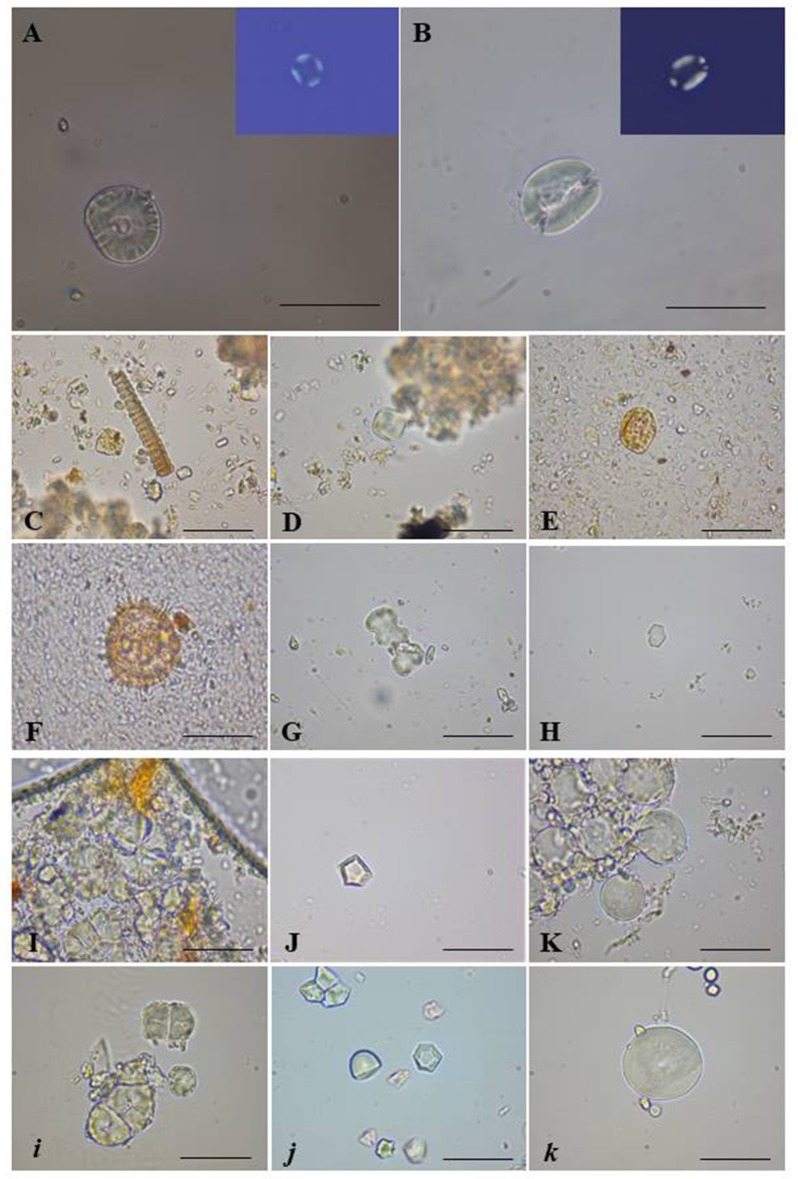
Examples of plant microremains found in the dental calculus of the samples.Starch granule of Triticum sp. and relative polarized image (A); starch granule of Fabaceae and relative polarized image (B); Poaceae phytoliths (C); not determined starch granule (D); fragment of Cucurbitaceae fruit epicarp (E); pollen grain of Asteraceae (F); Poaceae phytoliths (G); calcium oxalate crystal (H); starch granules of Myristica fragrans (I) and relative modern experimental reference (i); starch granule of Avena sp. (J) and modern experimental reference of Avena fatua (j); starch granules of Triticum sp. (K) and modern experimental reference of Triticum durum (k). The black bar indicates 15 μm.